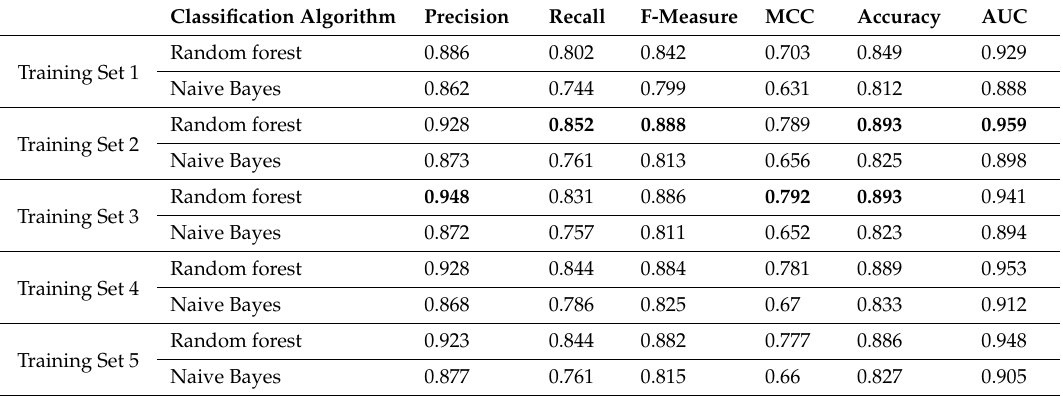
Table 3. Summary of performance calculated using both random forest (RF) and Naive Bayes (NB) classification algorithm for 5 di ff erent training sets using 10-fold cross-validation, which includes 243 benign variants chosen randomly (5 times) along with 243 pathogenic variants. The training and testing were done using all 29 features.